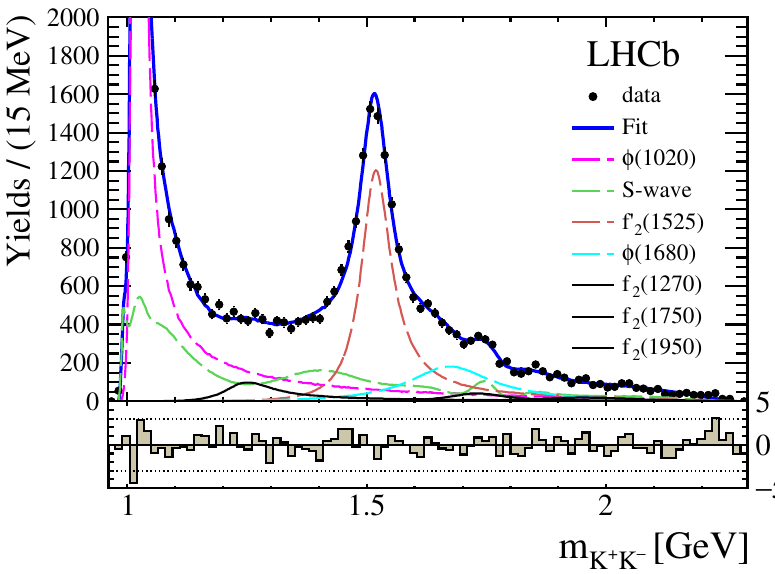
Figure 7 . Fit projection of m KK . The points represent the data; the resonances (cid:30) (1020), f 0 (cid:30) (1680) are shown by magenta, brown, and cyan long-dashed curves, respectively; the S-wave component is depicted by green long-dashed curves; the other f 2 resonances are described by black solid curves; and the total (cid:12)t by a blue solid curve. At the bottom the di(cid:11)erences between the data and the (cid:12)t divided by the uncertainty in the data are shown.